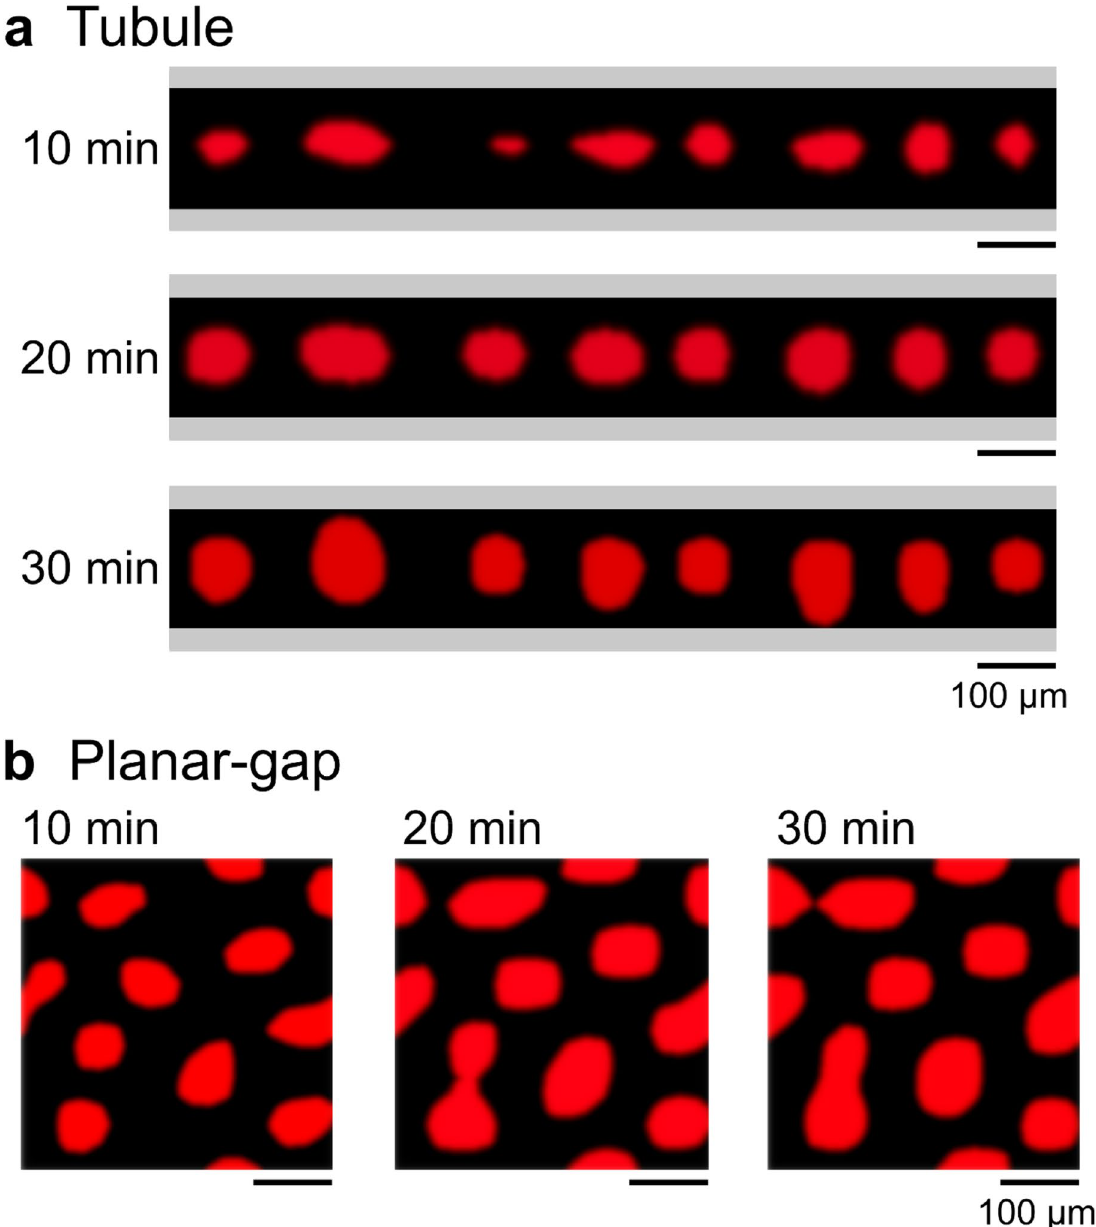
Figure 3. Numerical results regarding the time-development of micro-droplets. The numerical simulation for the phase-segregation was performed with the model equations (Eqs. (1) – (3)). The red region (η ≥ 0.6 ) corresponds to DEX-rich droplets and the black region represents PEG-rich solution. ( a ) With Tubule confinement, the phase-segregated droplets with varied morphology tend to transform into a circular shape of similar size over time. The gray area represents the glass wall of the capillary. In the simulation, the boundary condition along the surface was taken to follow the conservation law and to prefer the PEG-rich solution (η < 0.5 ). In contrast, for confinement with a Planar-gap as in ( b ), droplets tend to merge into larger droplets over